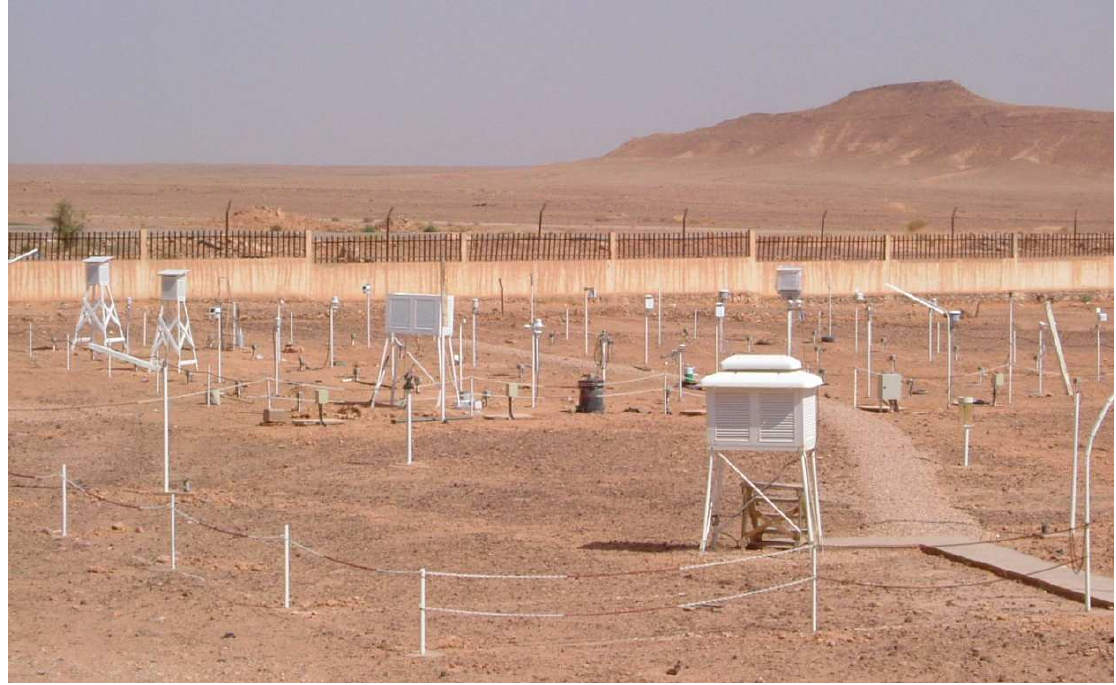
Figure 2. Picture of the experiment site. Source: Lacombe et al.